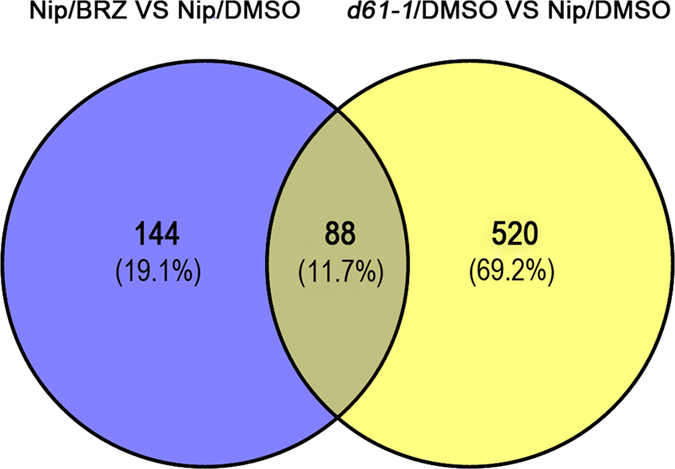
Venn diagram illustrating the number of identified proteins with abundance changed in the embryos of both BRZ treated Nip and d61-1 mutant.